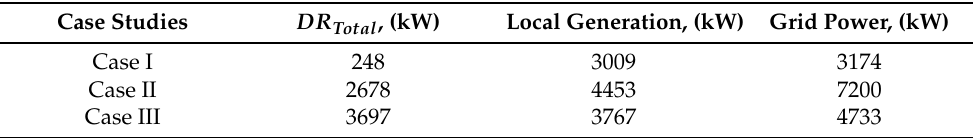
Table 3. Power requirements for each case study.